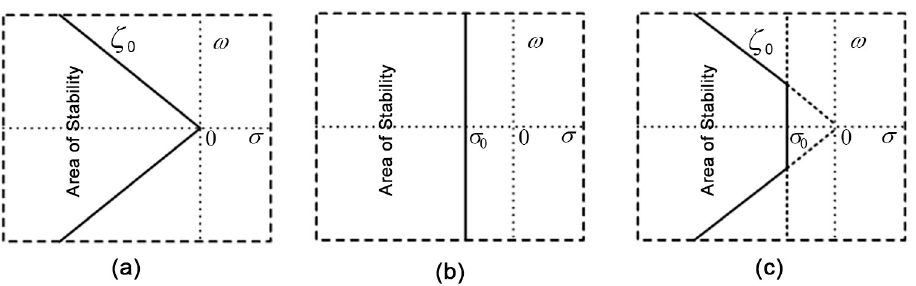
Fig 5. Formulation of the multi-objective D-shaped cost function for stability analysis in the s-plane. a) Stability defined by the expected damping ratio; b) Stability defined by the expected damping factor; c) Combination of the expected damping ratio and